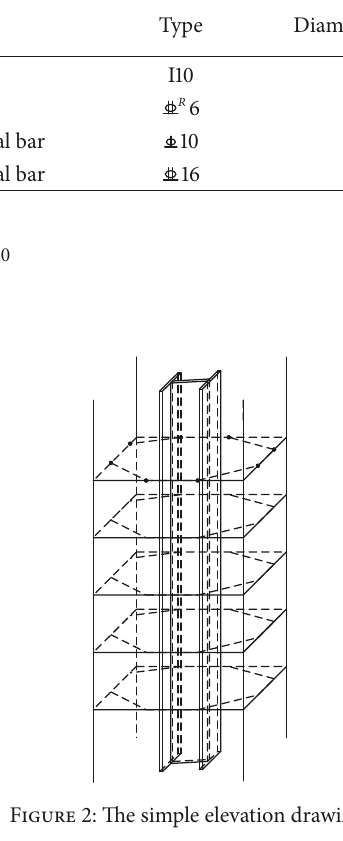
Figure 2: The simple elevation drawing.